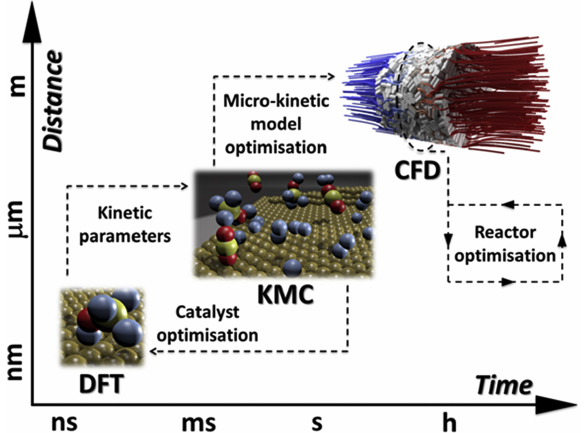
Figure 2. A schematic representation of the multiscale modeling, with various methods representing different temporal and spatial scales of the modeling phenomena. (Reprinted with permission from